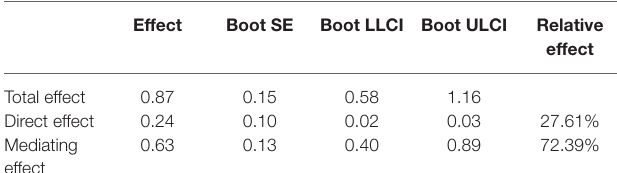
TABLE 1 | Total effects, direct effects and mediating